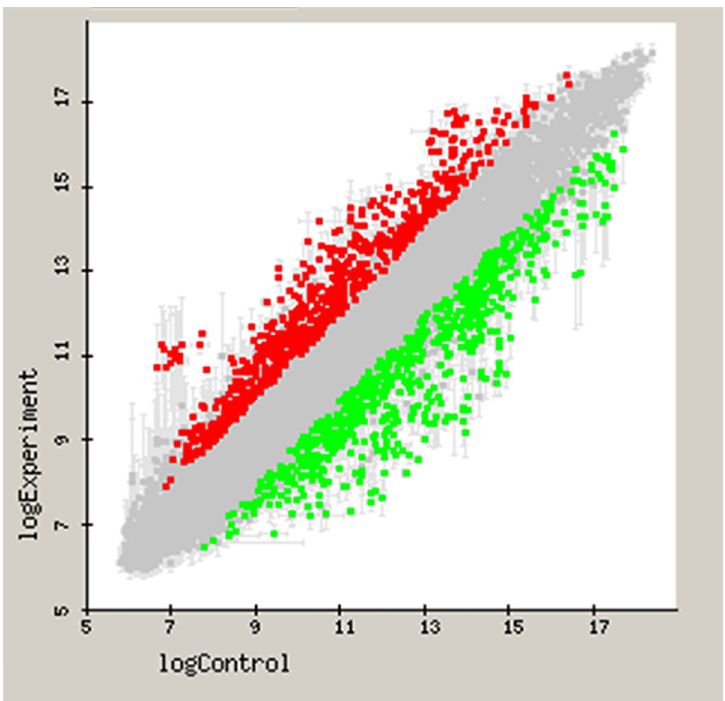
Fig 4. Microarray-based comparative transcriptome demonstrating the gene expression (represented in log 10 ) for Porphyromonas gingivalis ATCC 33277 when growing in a multispecies biofilm compared to planktonic growth. X-axis depicts the fold difference in gene expression of P . gingivalis in planktonic growth, and the Y-axis the gene expression of P . gingivalis inside a multispecies-biofilm. Up-regulated genes (over-expressed in multispecies-biofilm) were represented as red color and down-regulated genes were colored in green.